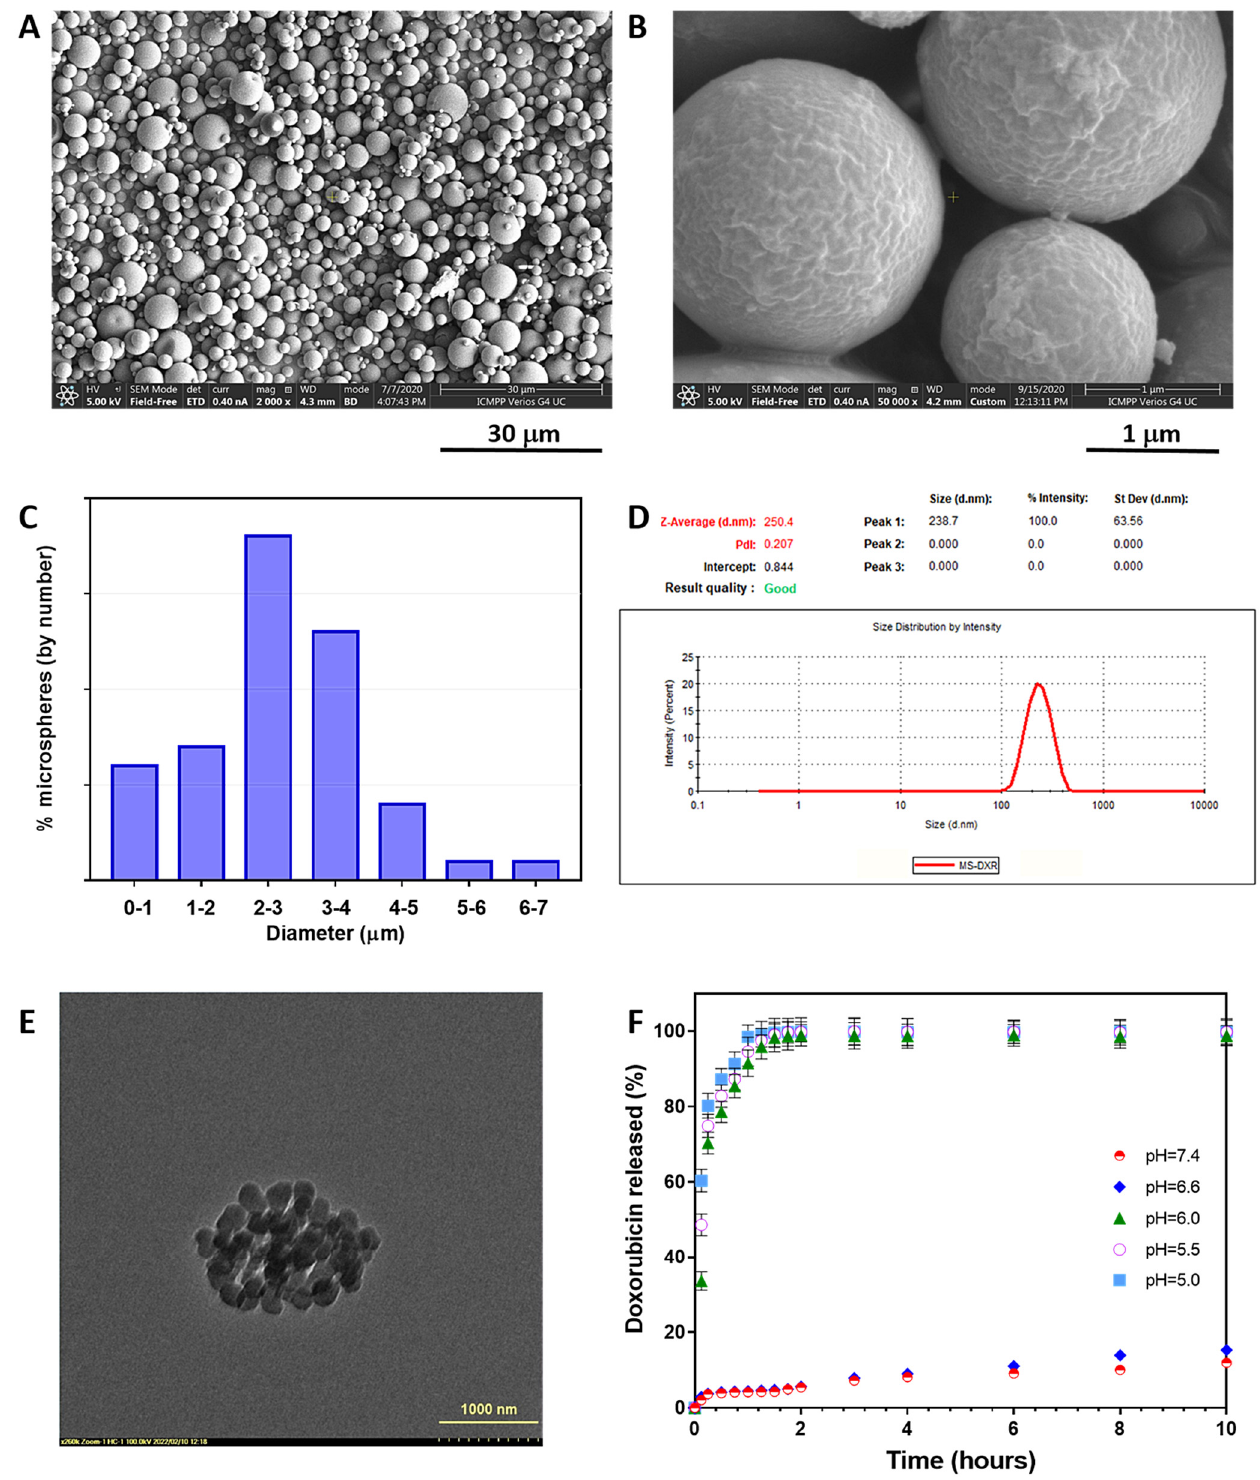
Figure 2. Particle characterization: scanning electron micrographs of DXR-loaded microspheres obtained by w/o solvent evaporation method ( A , B ); size distribution of microspheres ( C ); size distribution of NS-DXR in PBS (pH = 7.4) at 36 ◦ C ( D ). TEM image of NS-DXR ( E ). In vitro cumulative release (%) of DXR from NS-DXR under physiological conditions (PB) at pH = 7.4 (circles) and under slightly acidic conditions at pH = 6.6 (diamonds), 6.0 (triangles), 5.5 (empty circles), and 5.0 (squares) ( F ). Where statistical error bars are not shown, they are smaller than the symbols. Results are expressed as means ± standard deviation (S.D.).